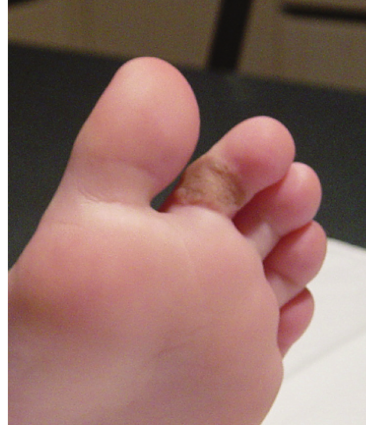
Figure 4: Delayed postoperative result (1 year after